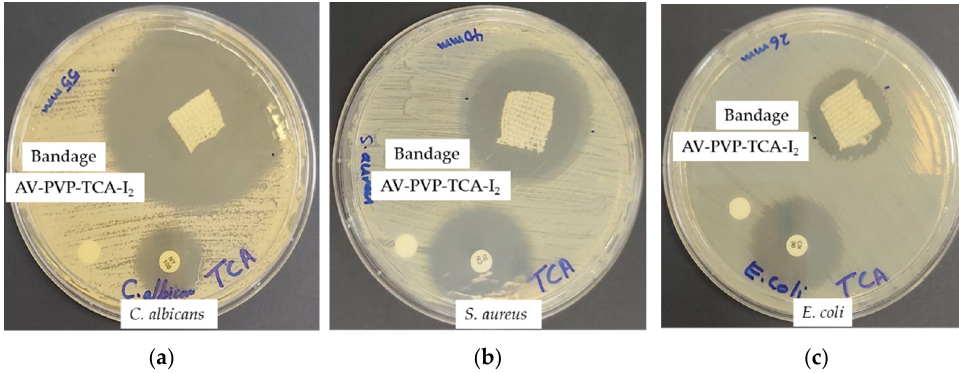
Figure 12. Impregnated sterile bandages with AV-PVP-TCA-I 2 . with positive control antibiotic nystatin (NY = 100 IU) and gentamicin (G = 30 µg/disc). From left to right: AV-PVP-TCA-I 2 (11 µg/mL) against ( a ) C. albicans WDCM 00054; ( b ) S. aureus ATCC 25932; ( c ) E. coli WDCM 00013. The Gram-positive S. aureus ATCC 25932 (40 mm) is followed in decreasing inhibitory action by S. pneumoniae ATCC 49619 and S. pyogenes ATCC 19615 (both 24 mm), E. faecalis ATCC 29212 and B. subtilis WDCM 00003 (both 23 mm) (Figure 11, Table 5). The three Gram-negative bacteria, K. pneumoniae WDCM 00097, E. coli WDCM 00013 and P. aeruginosa WDCM 00026, revealed inhibition zones of 28, 26 and 20 mm, respectively (Figure 12, Table 5).